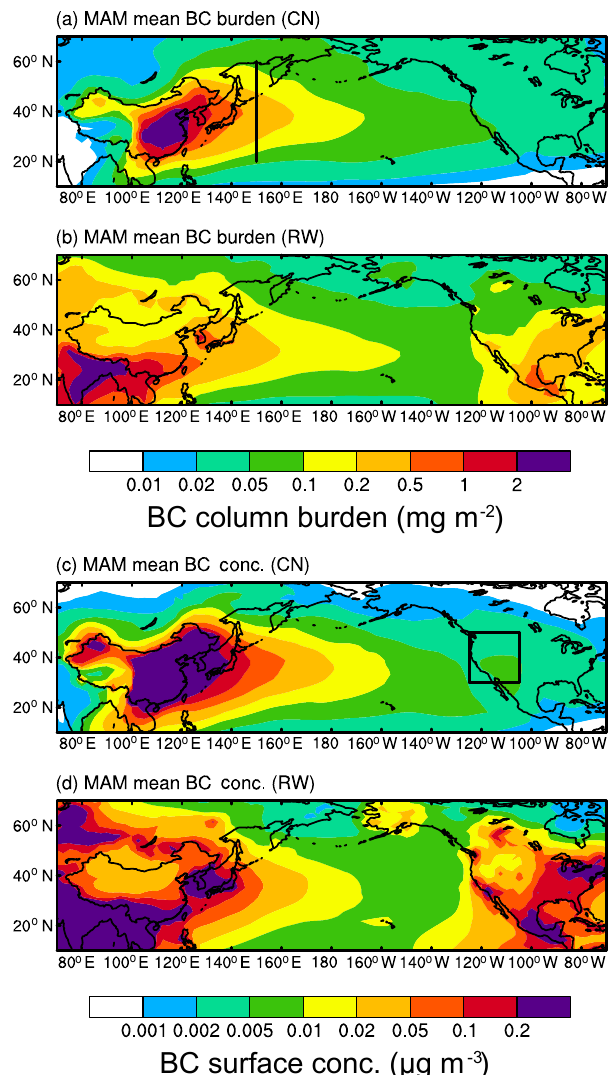
Figure 10. Spatial distribution of (a, b) column burden (mgm − 2 ) and (c, d) near-surface concentrations (µgm − 3 ) of BC originating from total emissions inside (CN) and outside China (RW) in March– April–May (MAM). The black solid lines over the western (150 ◦ E, 20–60 ◦ N) Pacific in panel (a) mark the cross-sections used to quan- tify outflow of BC from East Asia. The box over the western United States (125–105 ◦ W, 30–50 ◦ N) in panel (c) is used to quantify BC concentrations attributed to sources from China.